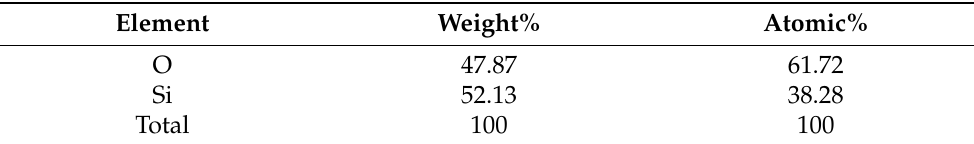
Table 2. Elemental composition of synthesized silica monolith particles (SMPs).